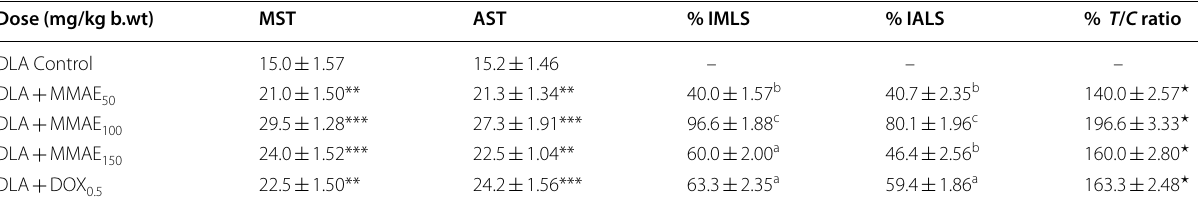
Table 2 Effect of MMAE and DOX treatment on DLA bearing mice on the tumor response assessment based on MST, AST, % IMLS, % IALS and T / C ratio